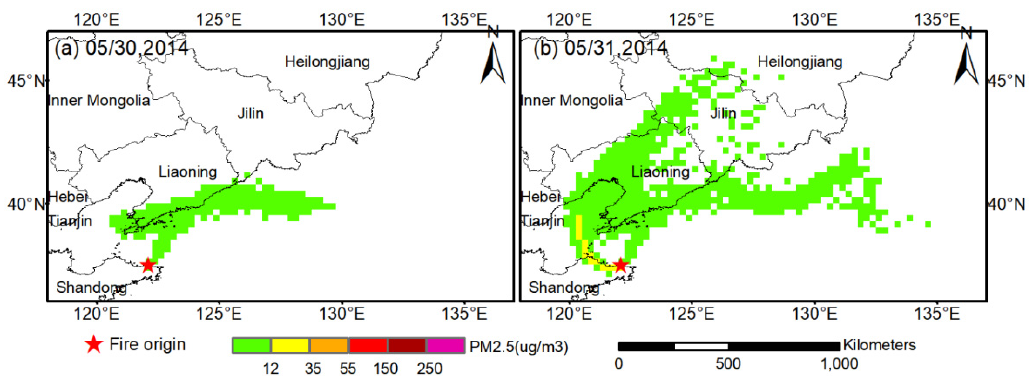
Figure A5. Same as Figure A1 except for the Weihai fire. Panels ( a , b ) are 30 and 31 May 2014, respectively.